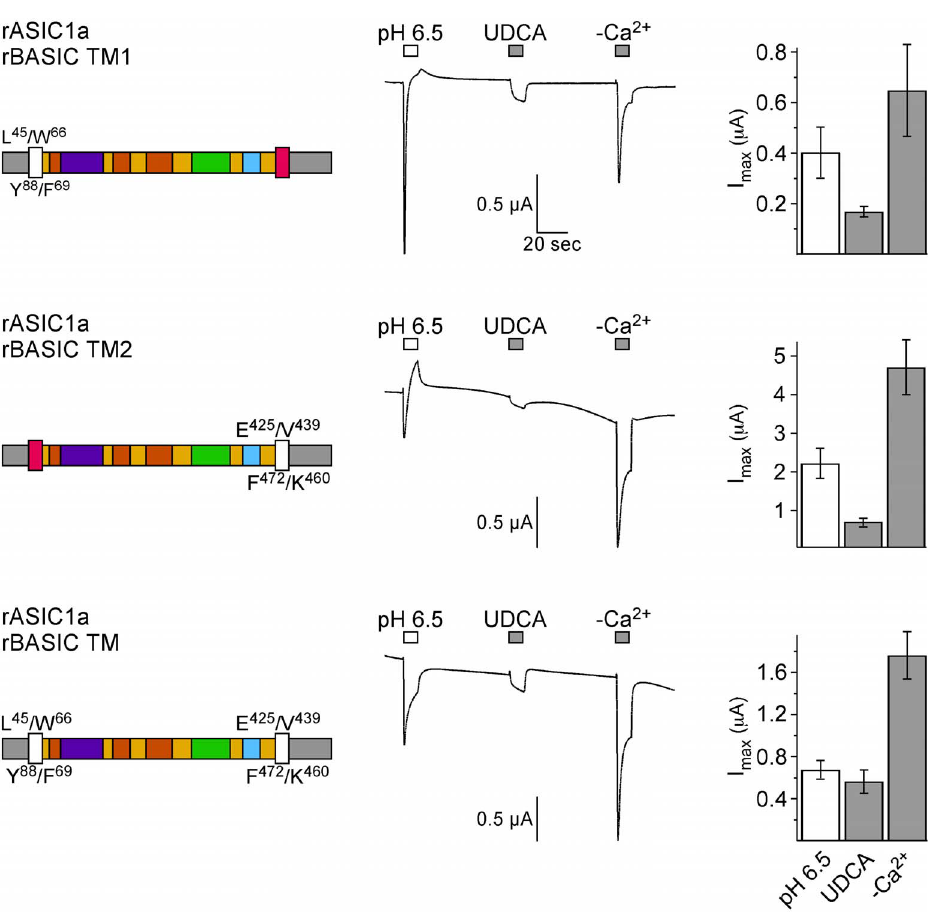
Figure 10. The TMDs of rBASIC are involved in bile acid sensitivity. Left panel, schematic drawings of chimeras; rASIC1a portions are depicted as in Fig. 5A, rBASIC portions are depicted in white. Residues defining the borders of the ASIC1a and BASIC sequences are shown. Middle panel, representative traces of currents induced by the subsequent application of pH 6.5, 2 mM UDCA, and removal of divalent cations (–Ca 2 + ). Right panel, quantitative comparison of current amplitudes induced by pH 6.5, UDCA and divalent cation removal. Error bars represent SEM; n =6–12.